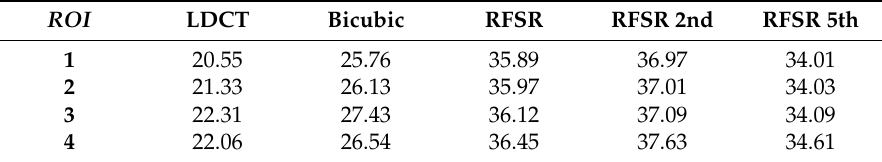
Table 4. The PSNR value of the four ROIs marked by red squares in Figure 5a.